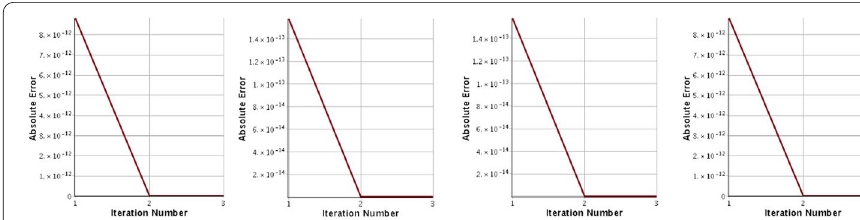
Fig. 4 Absolute errors at different iteration numbers for 8th BM with different θ ( θ = − 1, − 0.5,0.5,1 ) respectively for g 4 ( x ) .